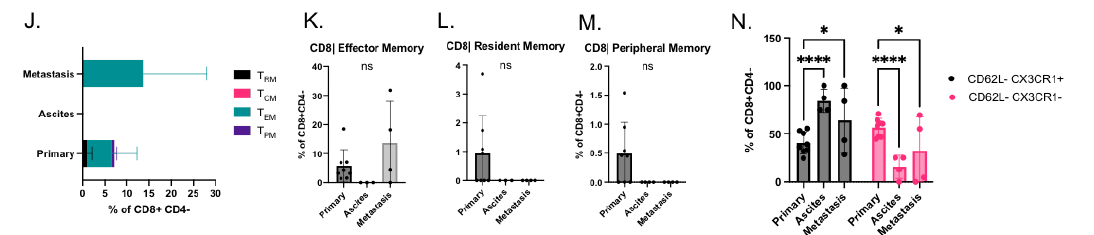
Figure 3. Profiling of Helper, Regulatory, and Memory T cell subsets in immune cells iso- lated from the different sites in STOSE.M1 luc murine ovarian intrabursal cancer model: ( A ) T Helper (Th) and T regulatory (T Reg) subsets as a % of CD4 + T cells in each site of STOSE.M1 luc ovarian intrabursal model, propagated in FVB/NJ mice. ( B ) Percentage of T Reg ( CD25 + FoxP3 + ) cells. ( C ) Percentage of Th2 cells (GATA3 + ). ( D ) Percentage of Th17 cells (ROR γ T + ). ( E , F ) Functional markers in T helper subsets. ( E ) Th2. ( F ) Th17. ( G ) CD4 + Memory T cell subsets in each site of STOSE.M1 luc model. ( H ) Percentage of CD4 + Effector Memory T cells (CCR7(lo)/CD62L(lo)/CX3CR1(hi)/CD27(lo)/CD127(hi)). ( I ) Percentage of CD4 + Resident memory T cells (CCR7(lo)/CD62L(lo)/CX3CR1(lo/int)/CD44(hi)/CD127(hi)/CD103(hi)). ( J ) CD8 + Memory T cell subsets in each site of STOSE.M1 luc ovarian intrabursal model. ( K ) Percentage of CD8 + Effector Memory T cells (CCR7(lo)/CD62L(lo)/CX3CR1(hi)/CD27(lo)/CD127(hi). ( L ) Percentage of CD8 + resident memory T cells (CCR7(lo)/CD62L(lo)/CX3CR1(lo/int)/CD44(hi)/CD127(hi)/CD103(hi)). ( M ) Percentage of CD8 + Peripheral Memory T cells (CCR7( + / − )/CD62L( + / − )/ Cx3CR1(int)/CD27 (hi) /CD127 (hi)). ( N ) CD62L and CX3CR1 expression of CD8 memory populations.